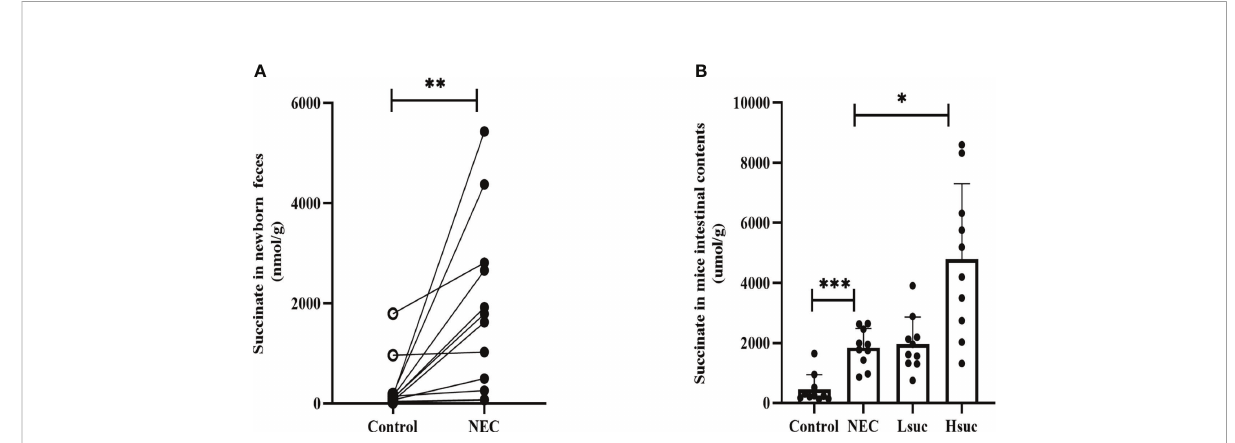
FIGURE 1 The levels of intestinal succinate were increased in both human neonates and mouse pups with NEC. Succinate levels (A) in feces from control and NEC human neonates (n=12 per group), and (B) in mouse intestinal contents from four independent groups (n=10 per group). Statistical